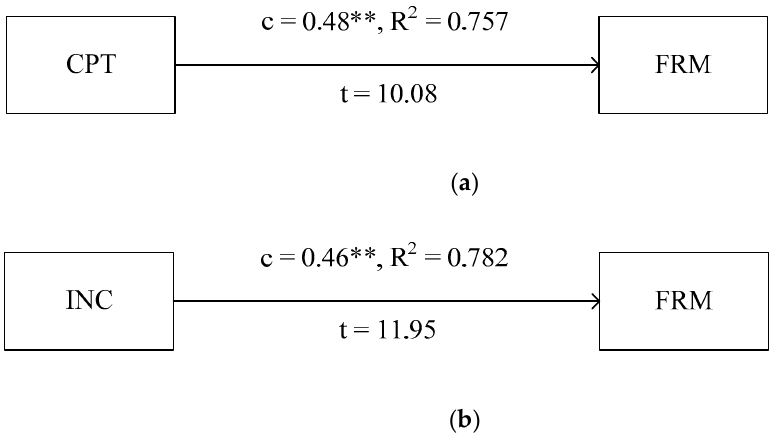
Figure 4. ( a ) Influence of the mediator (CPT) on the dependent variable (FRM). ( b ) Influence of the mediator (INC) on the dependent variable (FRM). Note: ∗∗ p < 0.001.